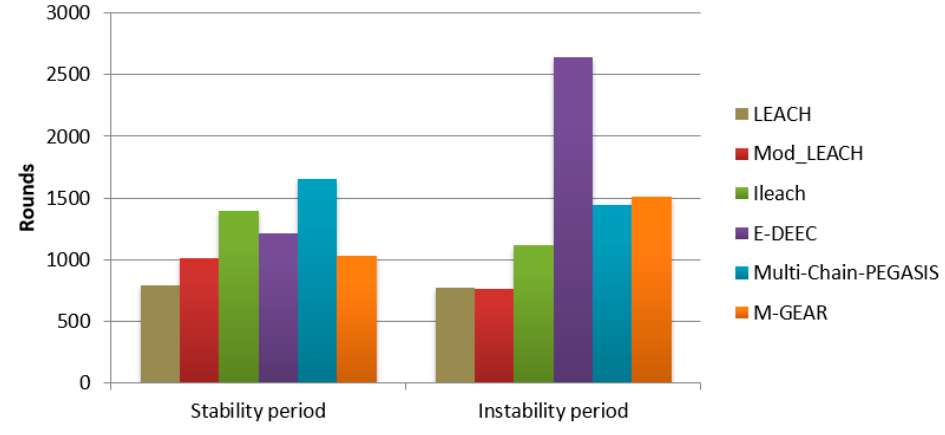
Figure 5. Stability and instability periods.